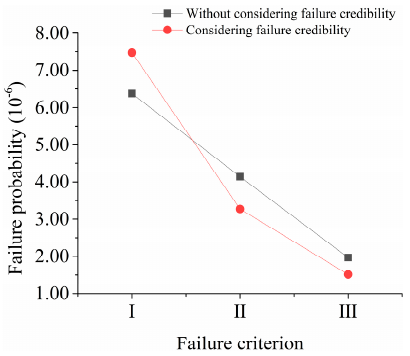
Figure 5. System reliability under different failure criteria considering failure credibility and not considering failure credibility.